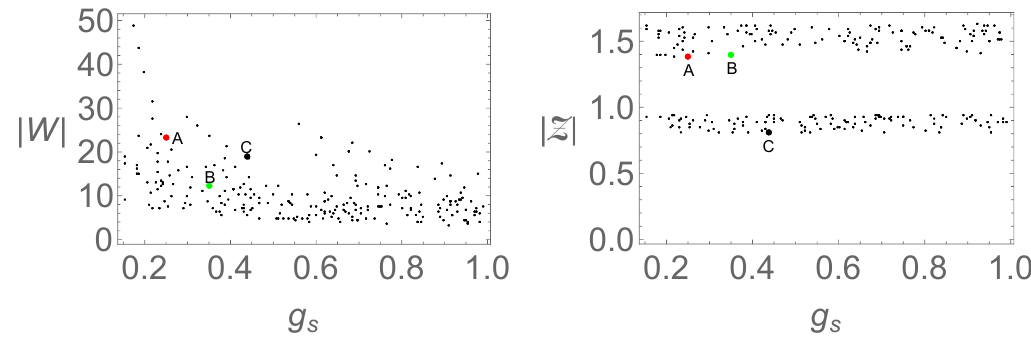
Figure 2 . Numerical results for the absolute values of (cid:13)ux superpotential j W j and a quantity jZj = e K= 2 j W j at the each of the solutions depicted in (cid:12)gure 1. tem in the framework of spacetime compacti(cid:12)cations, the vacuum energy at the each